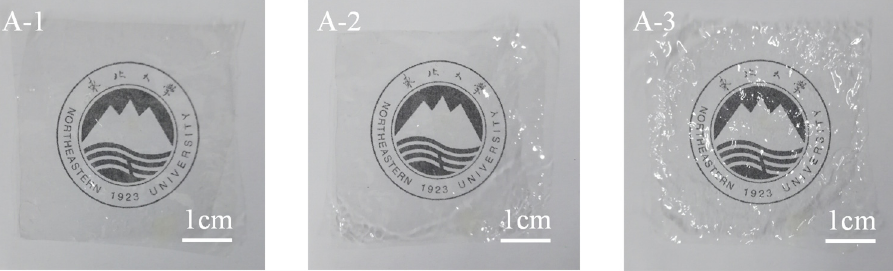
Figure 2. Digital images ( A ) of 25%PVP-PEKC ( 1 ), 50%PVP-PEKC ( 2 ) and 75%PVP-PEKC ( 3 ).